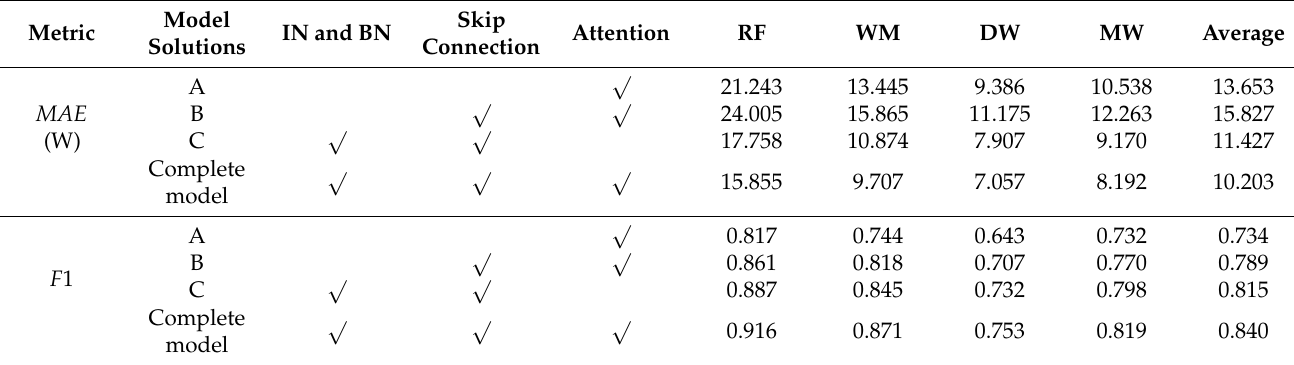
Table 2. Comparison of results of ablation